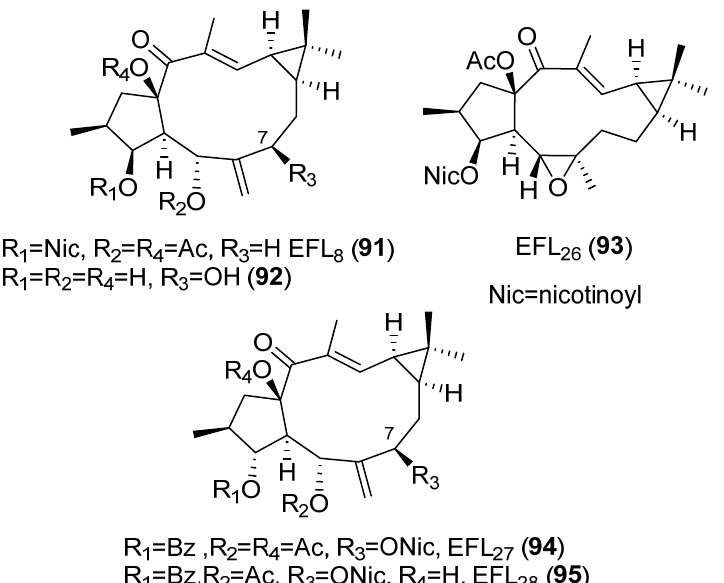
Figure 13. Chemical structures of compounds 91 – 95 .